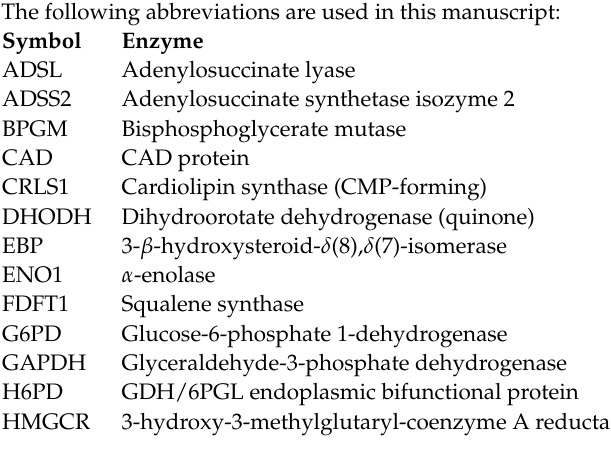
Table S1: Average AE grades for drugs acting on DHODH, Table S2: Average AE grades for drugs acting on HMGCR, Table S3: The log fold changes of metabolite-flows for the template, identified 2 anticancer target genes, and identified